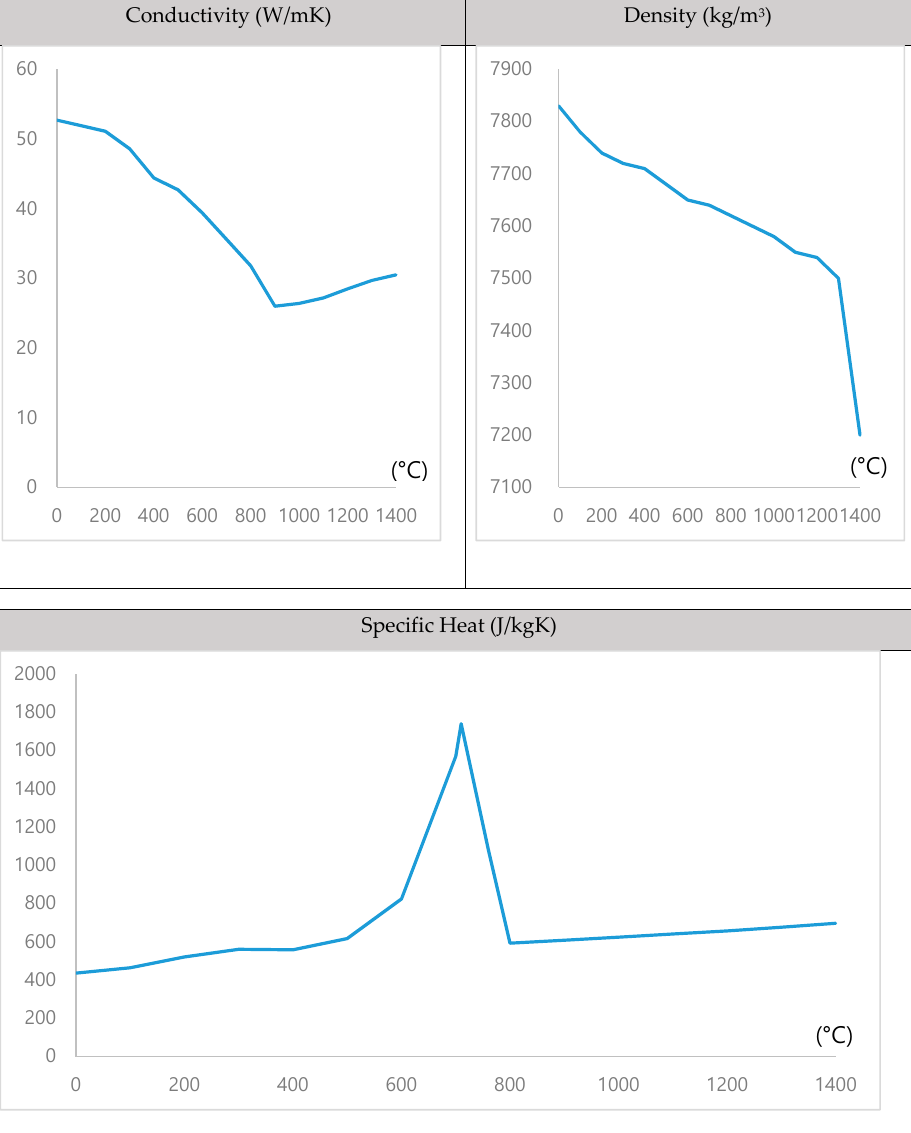
Figure 8. Material property of SS400 by temperature.